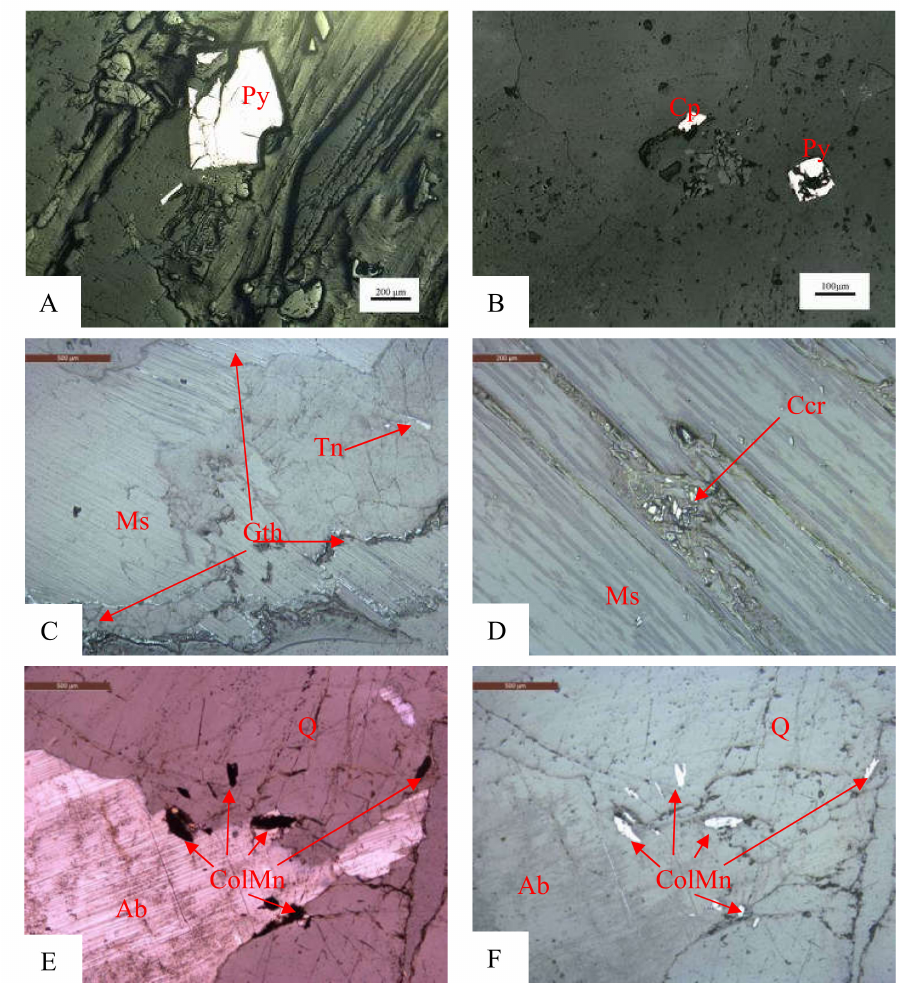
Figure 5. The major metallic minerals in the Lijiapuzi ore deposit. ( A ) Disseminated granular pyrite; ( B ) Paragenesis of chalcopyrite and pyrite; ( C ) Euhedral needle goethite along the cleavage and margin of muscovite, tantalite occurs as enclaves of quartz; ( D ) Cleavage of muscovite is metaso- matized and filled with calciouranoite minerals; ( E , F ) ColumbiteMn distribute along the margin of albite; Py-pyrite; Cp-chalcopyrite; Ms-muscovite; Tn-tantalite; Gth-goethite; Ccr-calciouranoite; ColMn-columbiteMn; Q-quartz. Notes: ( A – D ) are under reflected light; ( E , F ) are identically the same image, E is under transmitted cross-polarized light while F is under reflected